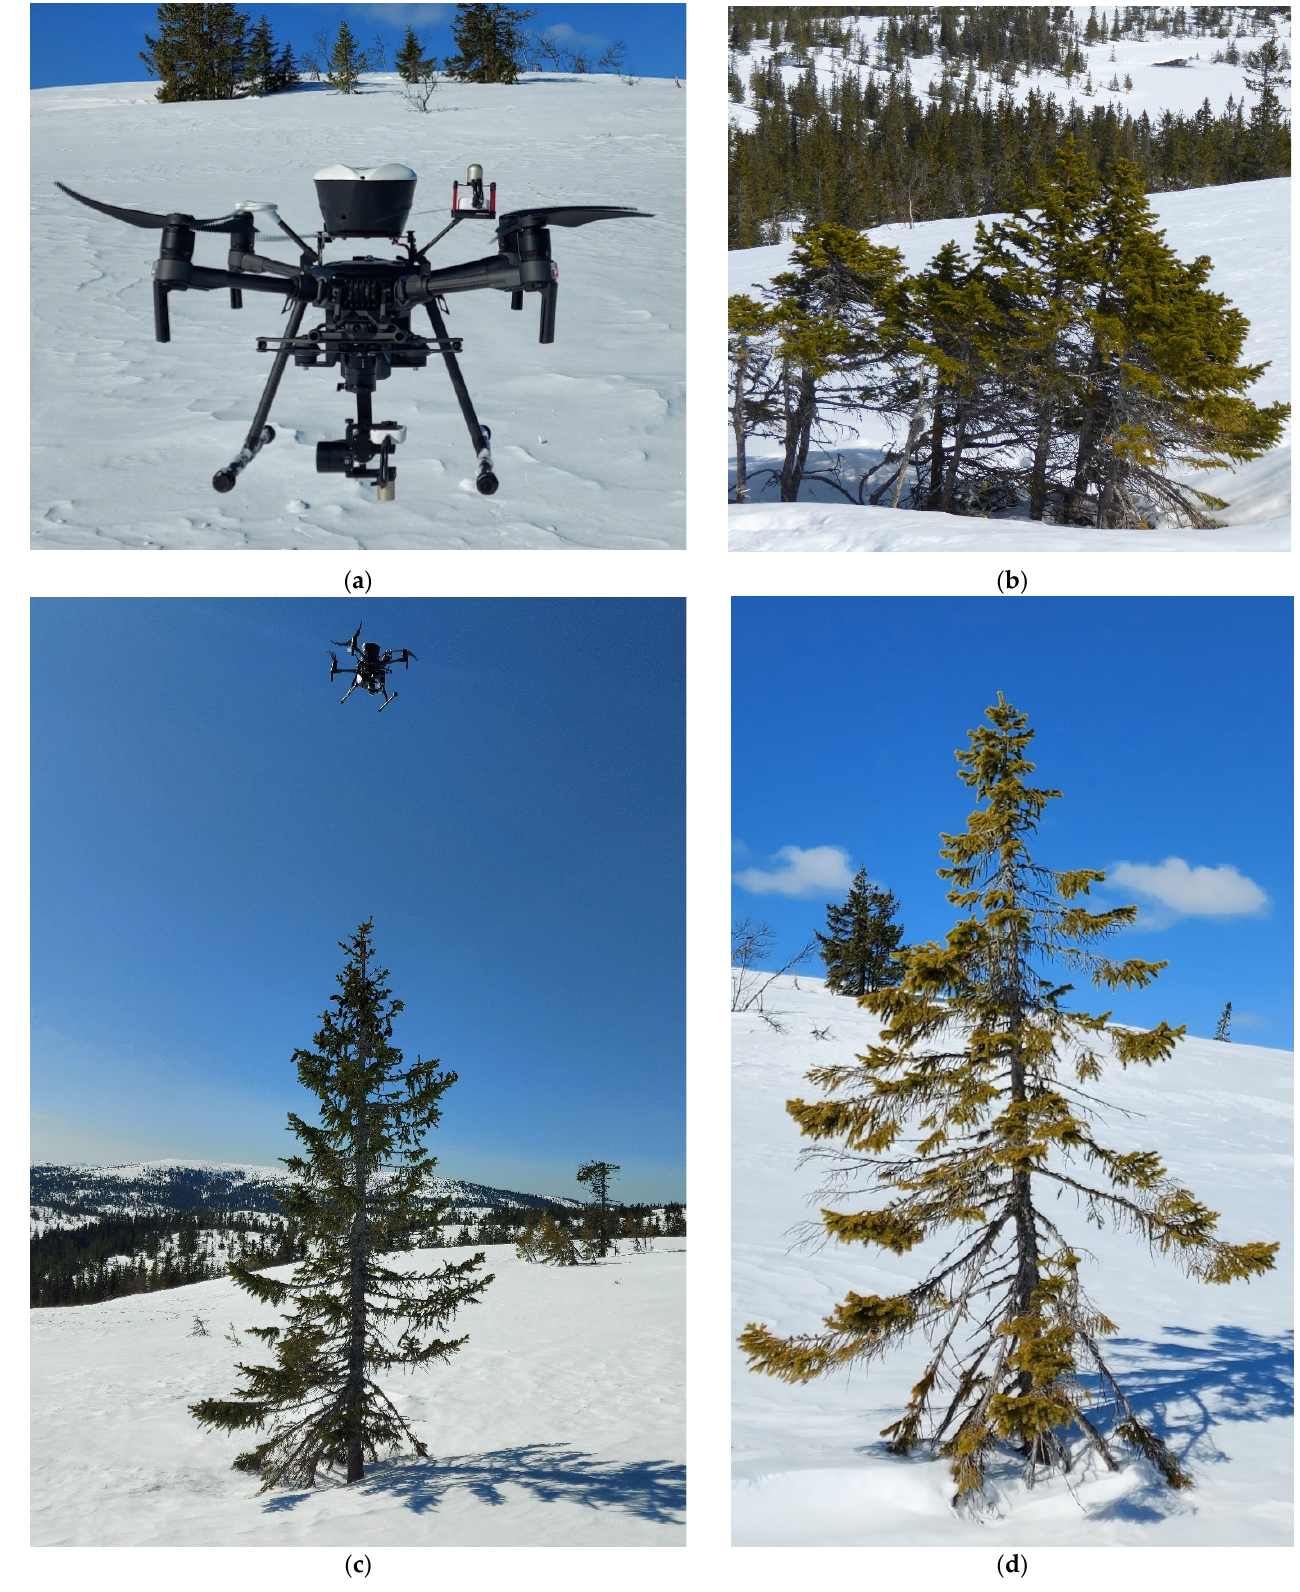
Figure 3. ( a ) Set-up of the UAV platform showing the upward- and downward-looking pyranometers, parachute safety system and external GPS receiver. ( c ) UAV in hoovering mode above one of the tree objects. ( b , d ) Two extremes of tree crown shape and crown width for two of the tree objects.